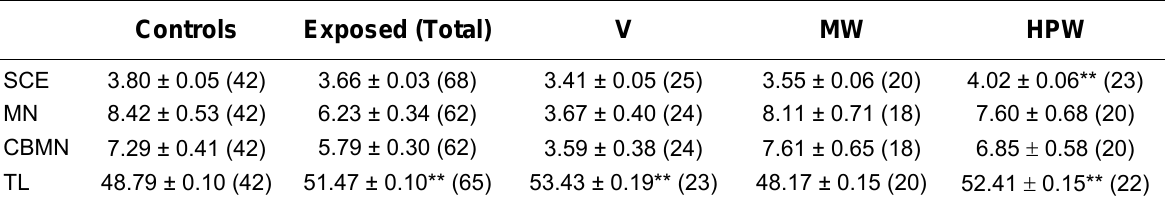
Effect of Exposure on the Genotoxicity Parameters Evaluated (mean ± SE) Controls